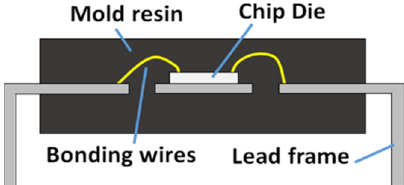
Figure 2. The simplified structure of a typical dual in-line package EC.